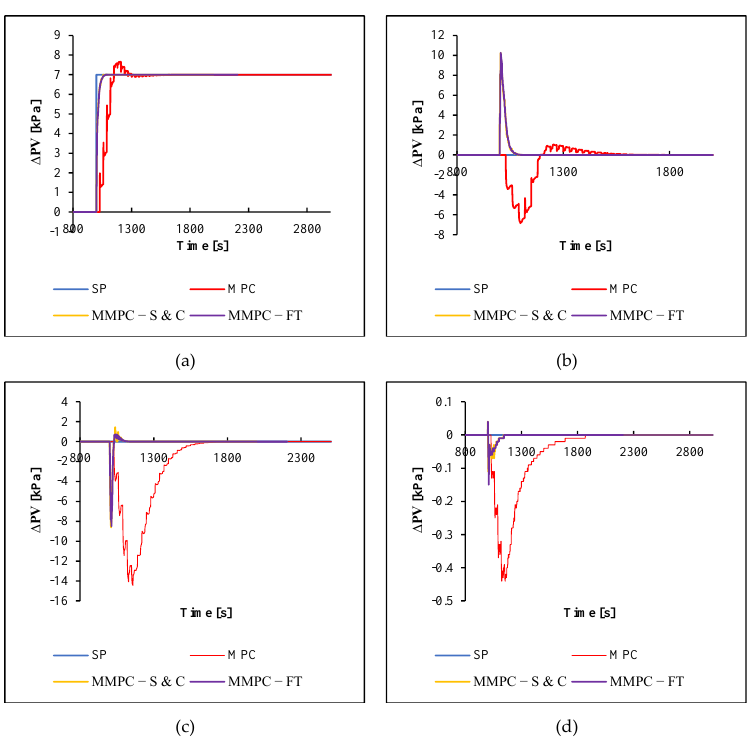
Figure 7. Comparison of controller performance with SP changes on compressor unit 1 (MIMO Model 2) on: ( a ) compressor unit 1; ( b ) compressor unit 2; ( c ) compressor unit 3; and ( d ) compressor unit 4.